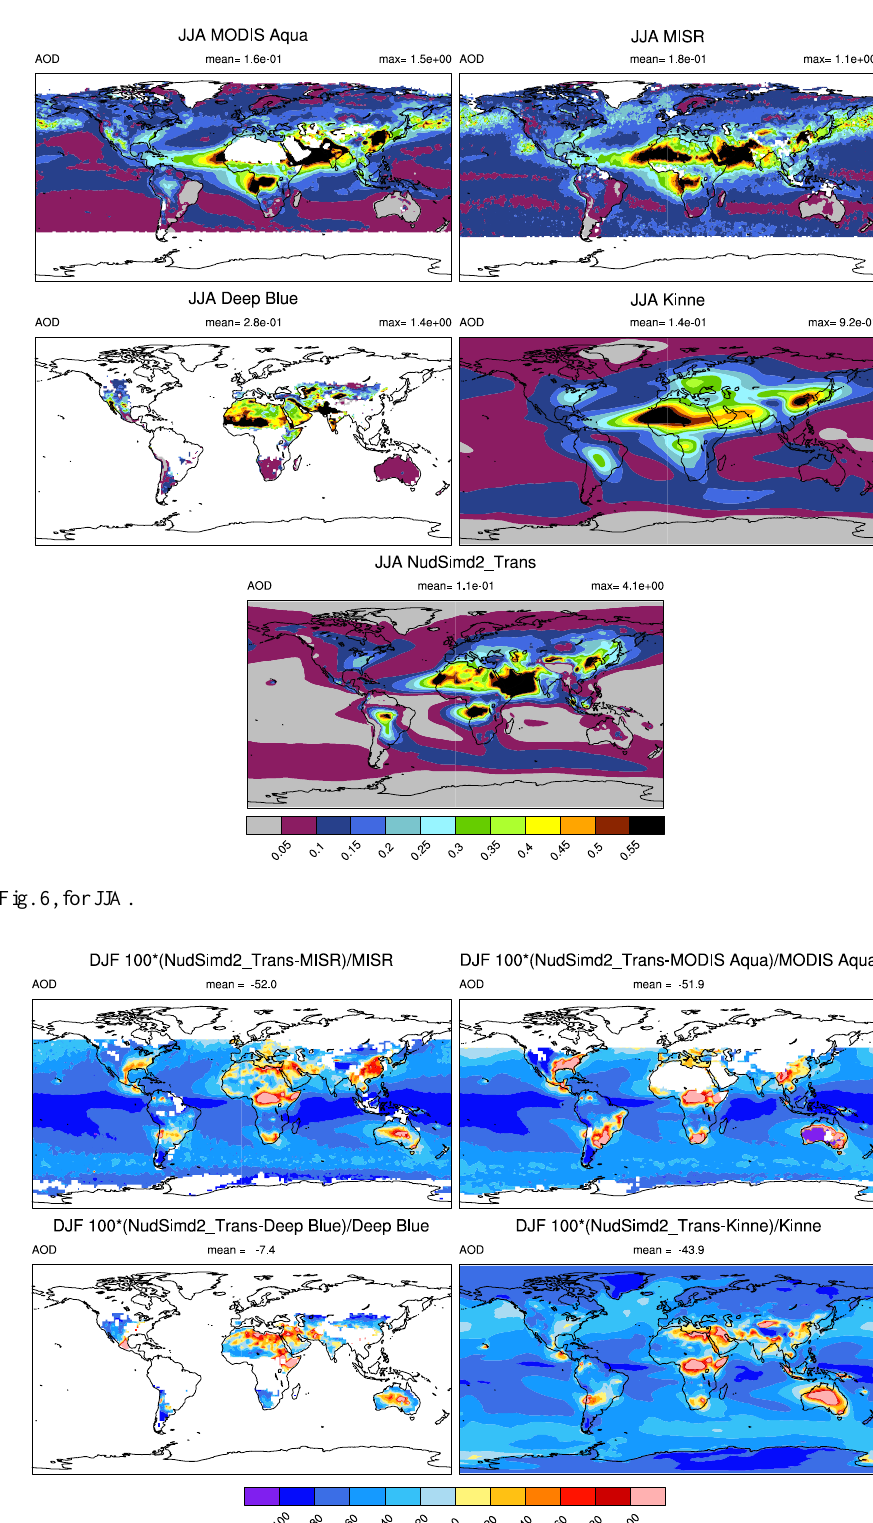
Figure 8. DJF total AOD mean relative differences (2003–2012): 100(NudSimd2_Trans − x ) /x , with x = MISR first row/column, x = Modis Fig. 8. DJF total AOD mean relative differences (2003-2012): 100(NudSimd2 Trans-x)/x, with Aqua, x = MODIS Deep Blue, and x = Kinne et al. (2013) in the direction of x=MISR first row/column, and x=Modis Aqua or x=MODIS Deep Blue or x= Kinne et al. (2013) in the direction of reading.